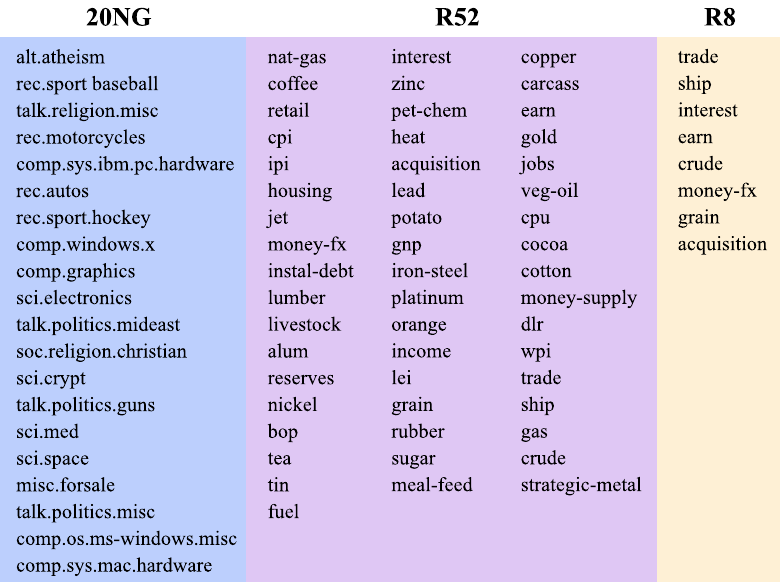
Fig. 6 Labels from the 20NG, R52, and R8